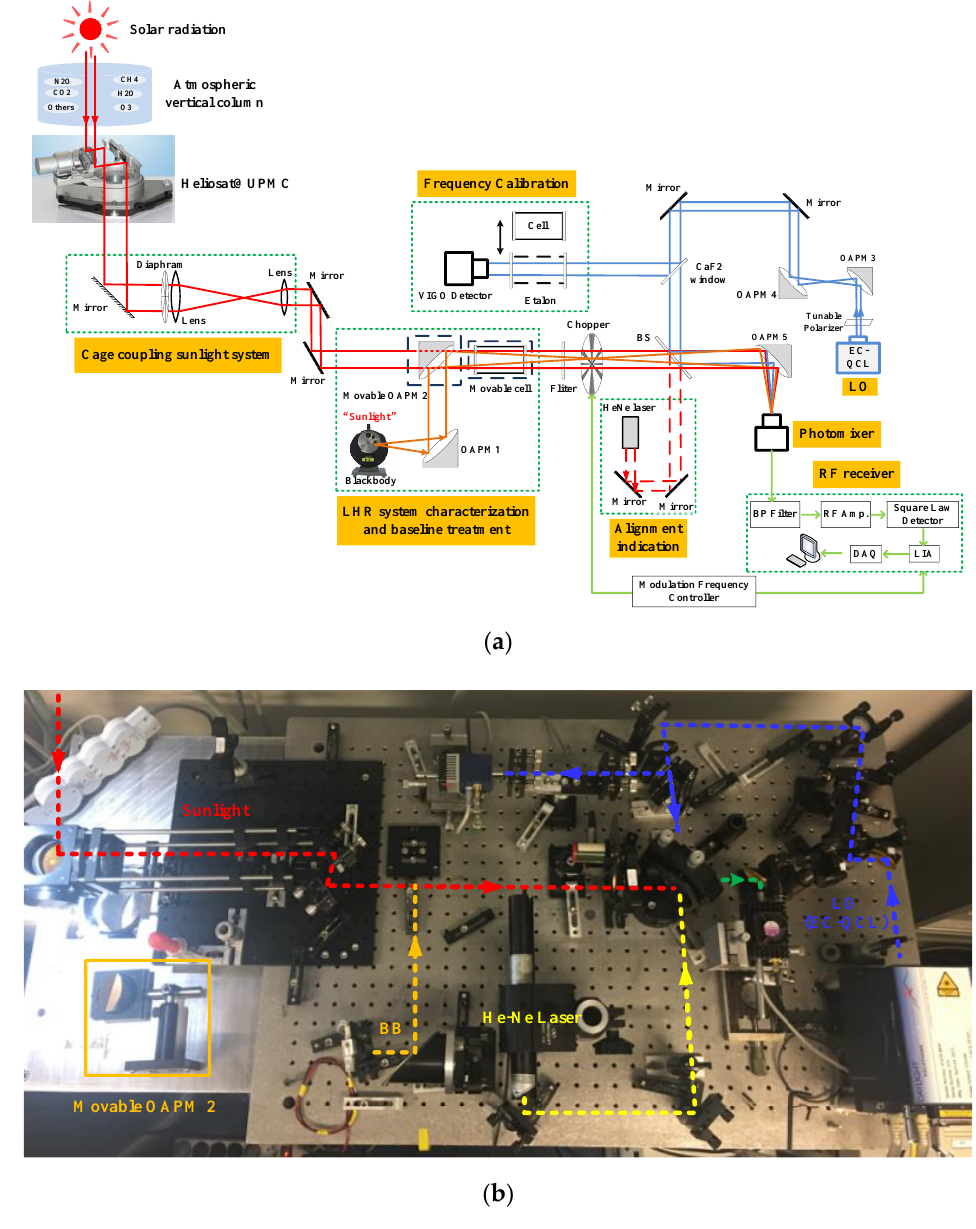
Figure 5. ( a ) Schematic of the developed LHR prototype. BB: Blackbody; EC-QCL: external cavity quantum cascade laser; OAPM: Off-axis parabolic mirror; BS: Beam splitter; BP Filter: Band-pass filter; DAQ: Data acquisition card. ( b ) Picture of the mid-IR LHR receiver (without sun-tracker part). Red dot line: sunlight beam path; orange dot line: blackbody beam path; yellow dot line: He-Ne laser beam path; blue dot line: EC-QCL beam path; green dot line: combined LO-BB beams to the photomixer.